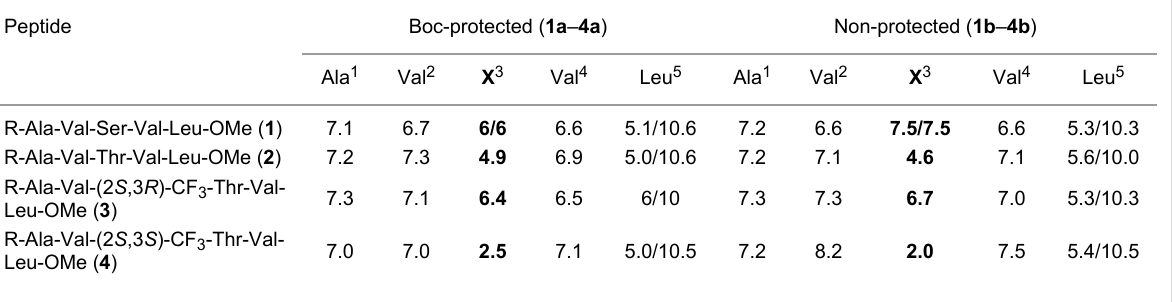
Table 4: 3 J H α –H β coupling constants (Hz) for peptides 1a – 4a and 1b – 4b in CD 3 OH. Coupling constants were extracted from 1D 1 H spectra on multi- plets of H β protons for Ala or H α protons for other residues. Peptide